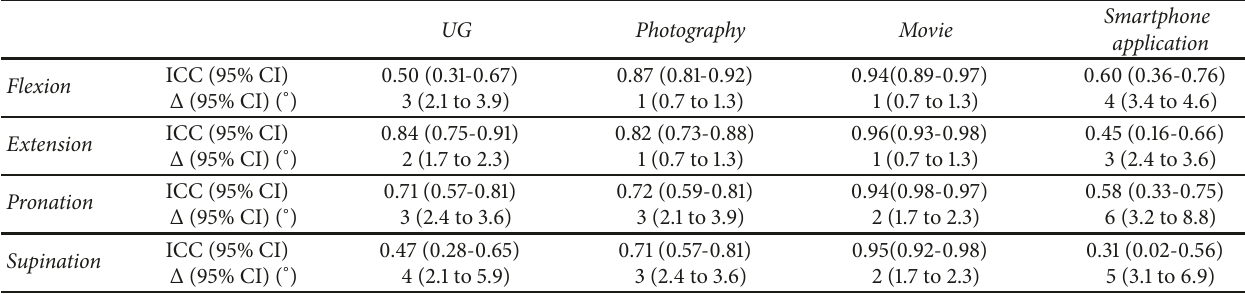
Table 3: Intraobserver reliability (ICC) and mean difference ( (cid:2) ) and 95% CI of UG, photography, and movie and smartphone application measurements. UG Photography Movie